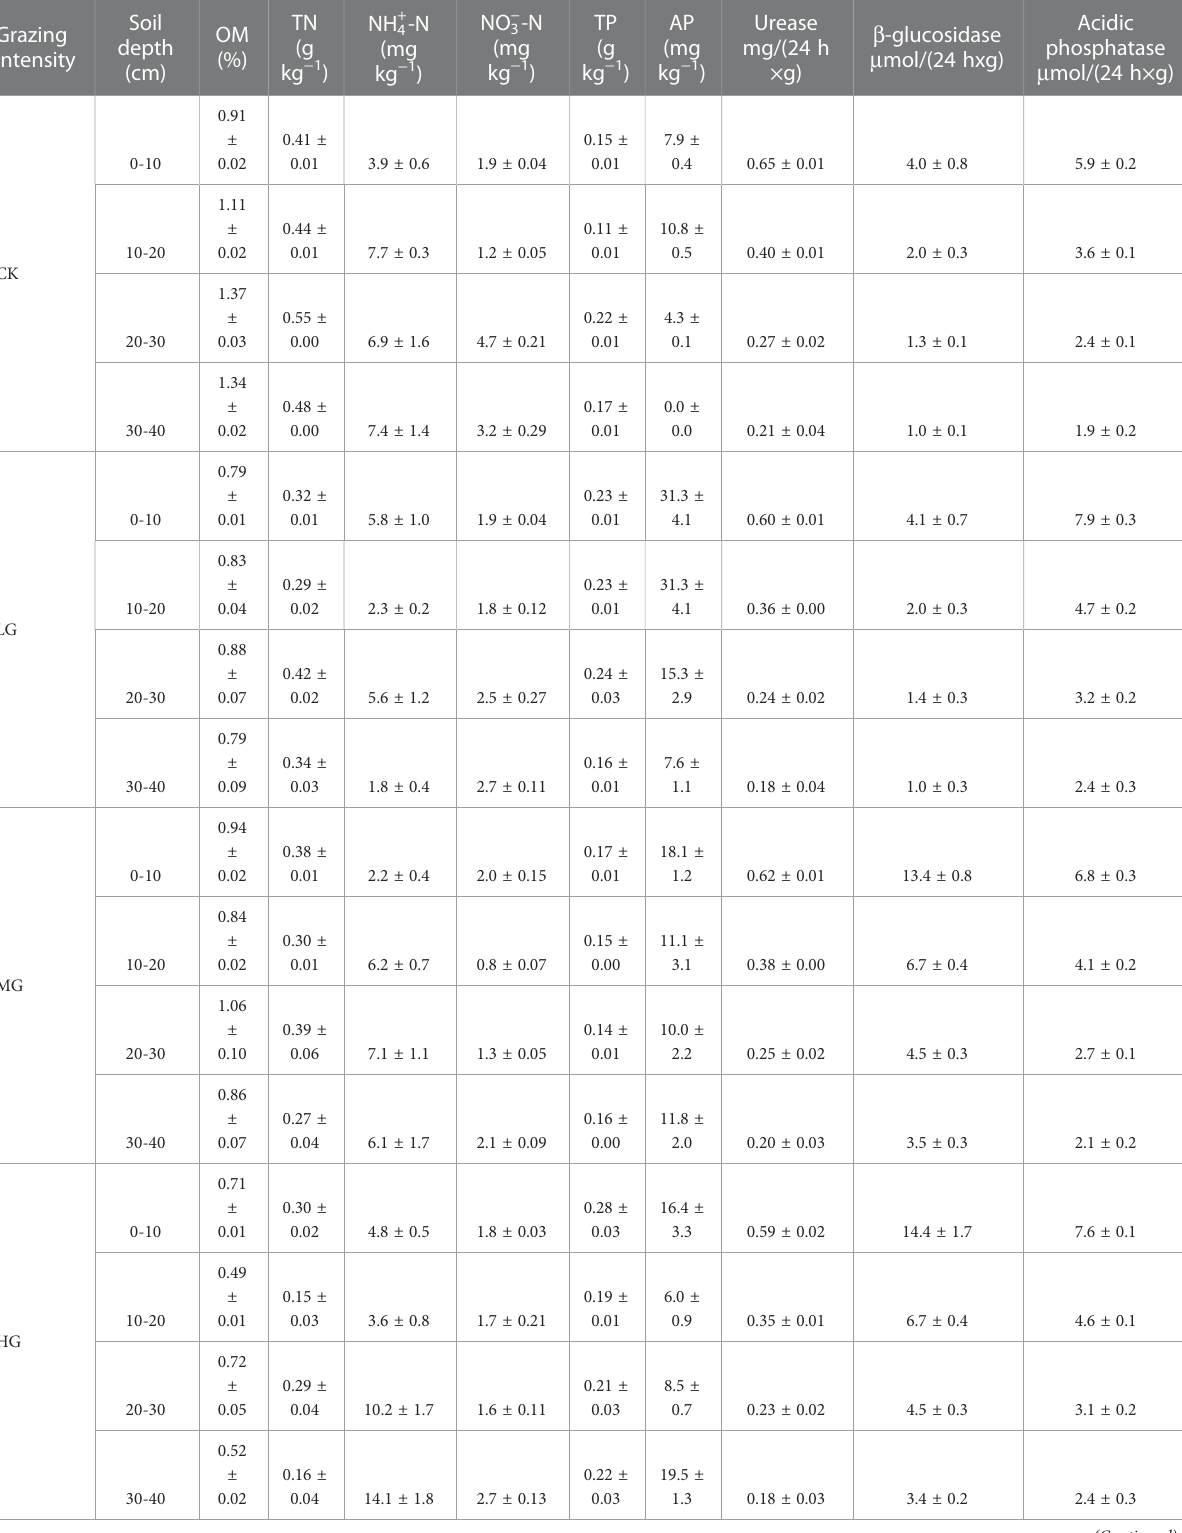
TABLE 1 Effects of grazing intensity and soil layer on the soil properties, mean value ± SE, n = 6 subplots, with statistical results of the general linear model ( P value).